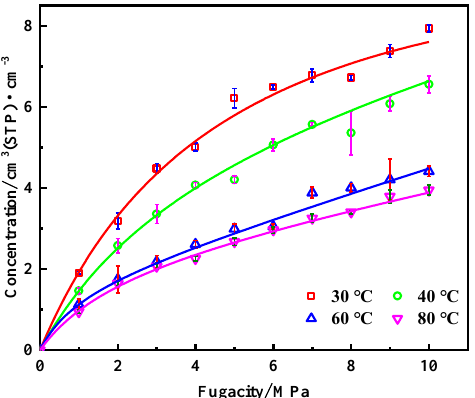
Figure 4. Adsorption isotherm of CH 4 in PVDF containing crude oil.